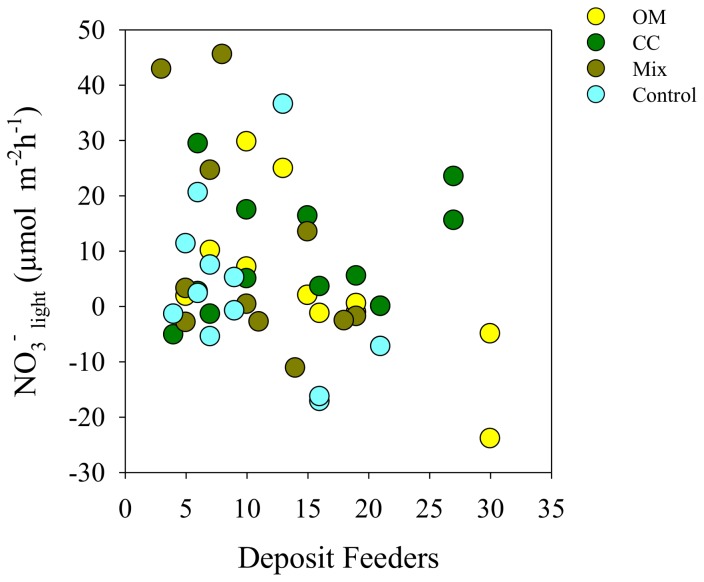
Relationship between nitrate flux during daylight (µmol NO3
−
light m−2h−1) and the abundance of deposit feeders.The panel shows the general relationship across the sampling area. Plots are raw data. (Treatments: Organic Matter, Calcium carbonate, Mix, Control).